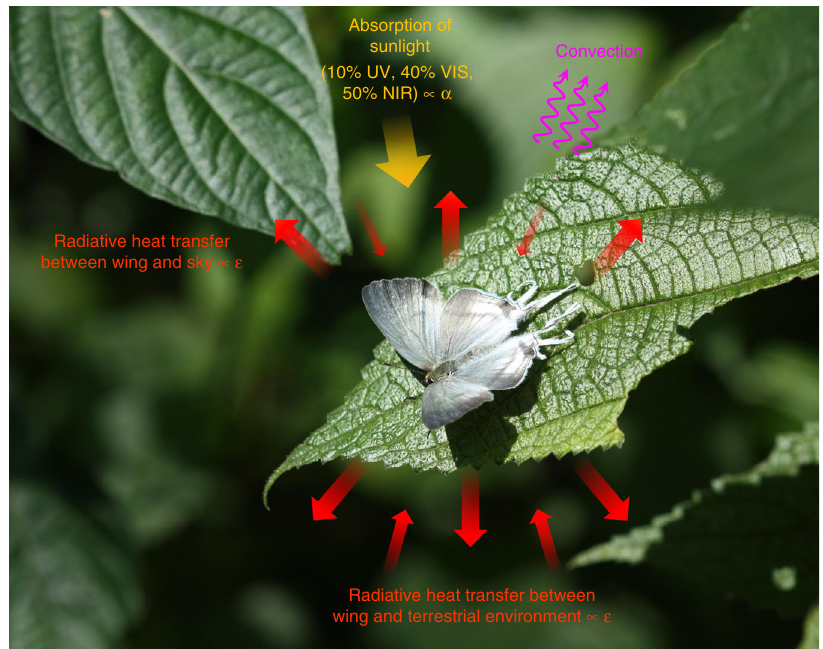
Fig. 3 Thermodynamics of butter fl y wings. A female Hypolycaena hatita basking in the sun. Steady-state wing temperature is the result of a balance between absorption of sunlight (orange arrow), convective heat loss to the surrounding air (purple arrows), and radiative energy exchange between the heated wing and the relatively cold surrounding environment (red arrows). Heating by sunlight is determined by solar absorptivity, and ability to dissipate heat through thermal radiation is governed by thermal emissivity; therefore, understanding the properties of butter fl y wings in the solar spectrum (where the ultraviolet, visible, and near-infrared components contain ∼ 10%, ∼ 40%, and ∼ 50% of the solar energy, respectively) and in the thermal radiation spectrum ( λ = 3 – 20 μ m) is crucial to understand the thermodynamics of butter fl y wings. Dino J. Martins photographed the Hypolycaena hatita shown in this fi